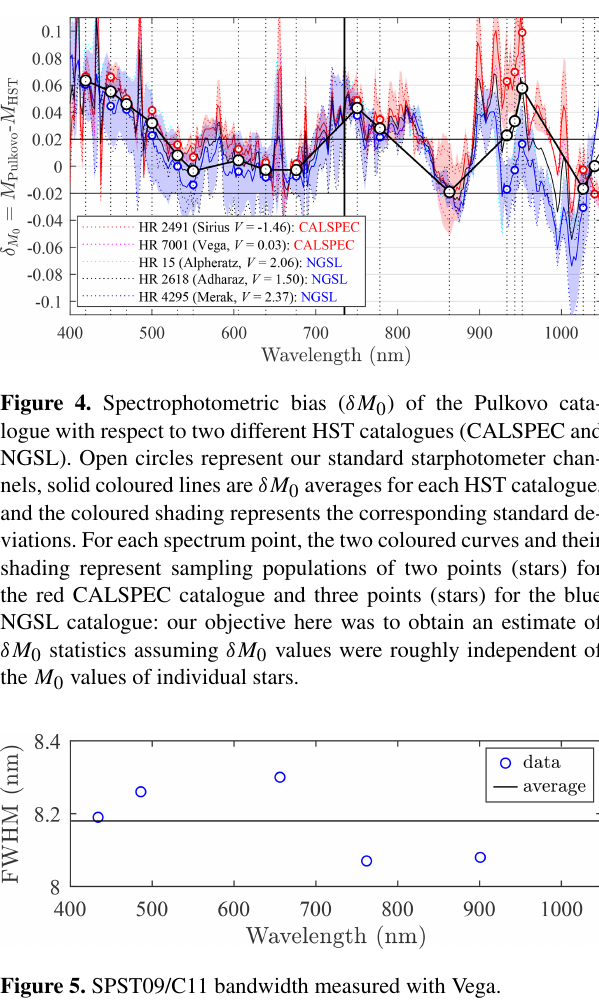
Figure 5. SPST09/C11 bandwidth measured with Vega.